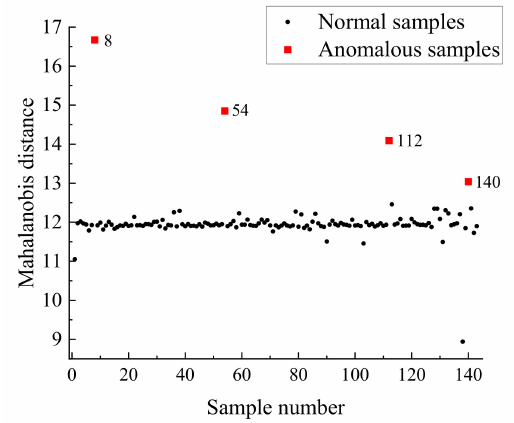
Figure 4. Mahalanobis distance for each sample.